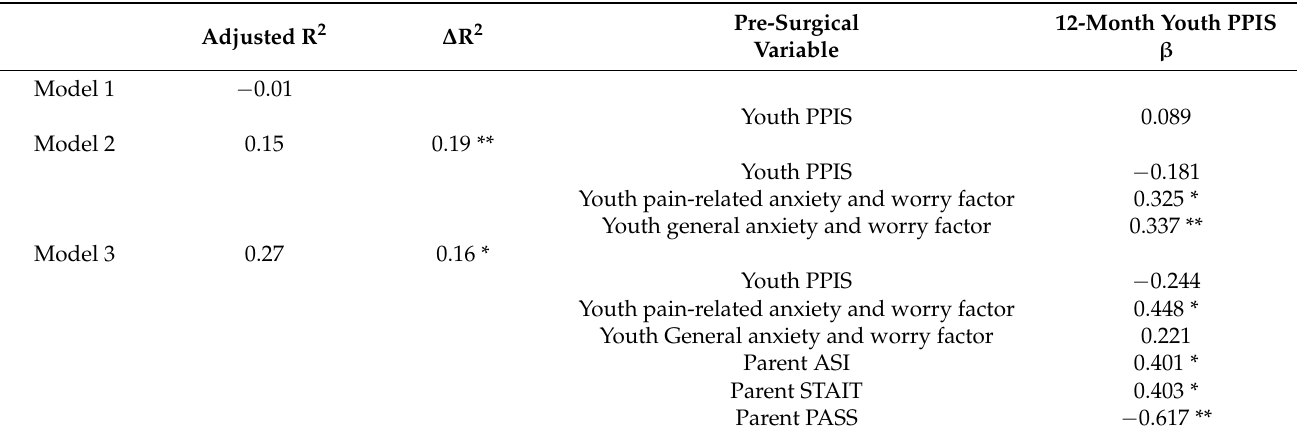
Table 3. Standardized regression coefficients ( β ) from multivariable regression analyses predicting 12-month youth PPIS from youth and parent pre-surgical risk